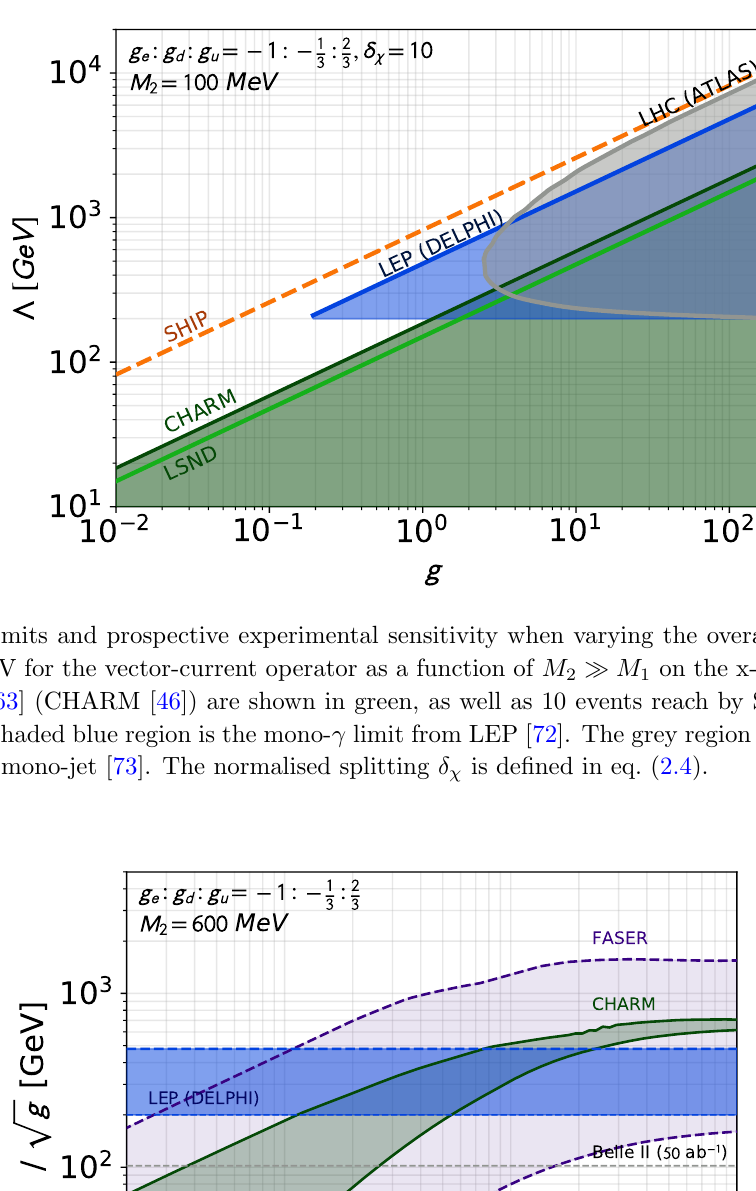
Figure 8 . Limits and projected sensitivity to (cid:3) = shaded blue region is the mono- (cid:13) limit from LEP [72]. Exclusion from CHARM [46] is shown in green, and projection from FASER [66] in purple.